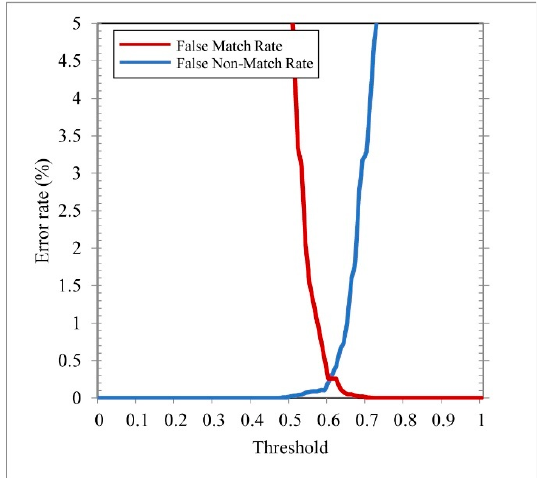
Figure 29. False match rate (FMR) and false non-match rate (FNMR) curves.